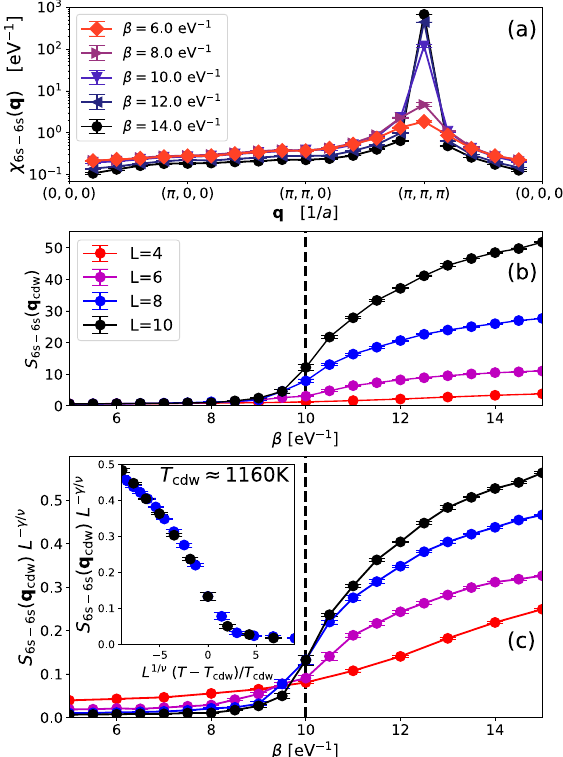
Fig. 2 Finite-size scaling to determine transition temperature T cdw . a The charge susceptibility plotted on a semilog scale for an L = 10 cluster. As the